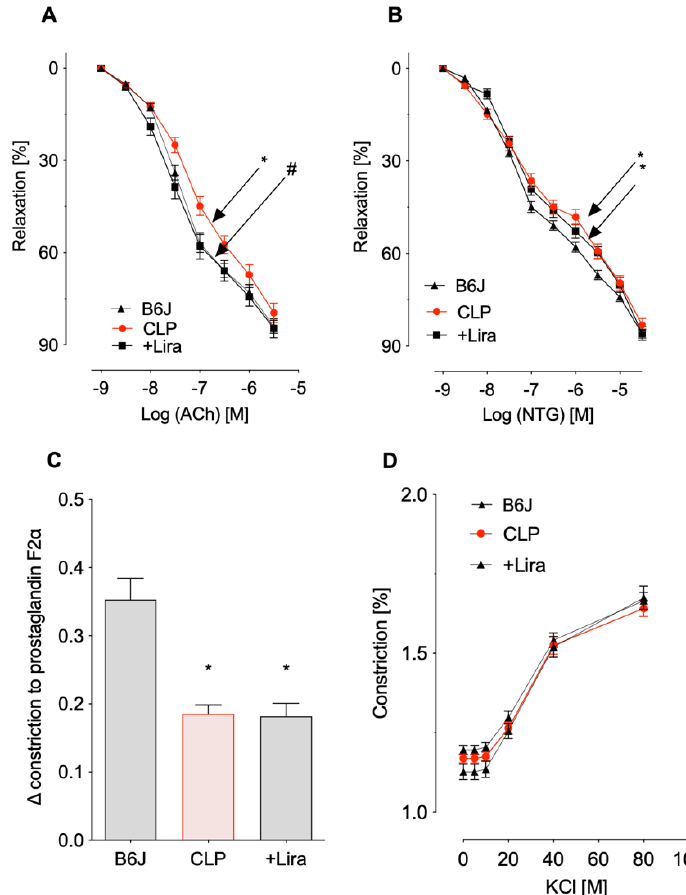
Figure 2. Treatment with the GLP-1 receptor agonist liraglutide prevents CLP-induced endothelial dysfunction in polymicrobial septic mice. ( A , B ) Endothelium-dependent (acetylcholine, ACh) and independent (nitroglycerine, NTG) relaxation of thoracic aortic rings was measured in isometric tension recordings. ( C , D ) Vasoconstrictor responses prompted by 2 μM prostaglandin F2α and increasing concentrations of KCl. Data are the mean ± SEM of 22–34 ( A ), 21-35 ( B ) or 26–36 ( C , D ) independent measurements. * p < 0.05 vs. B6J; # p < 0.05 vs. CLP.